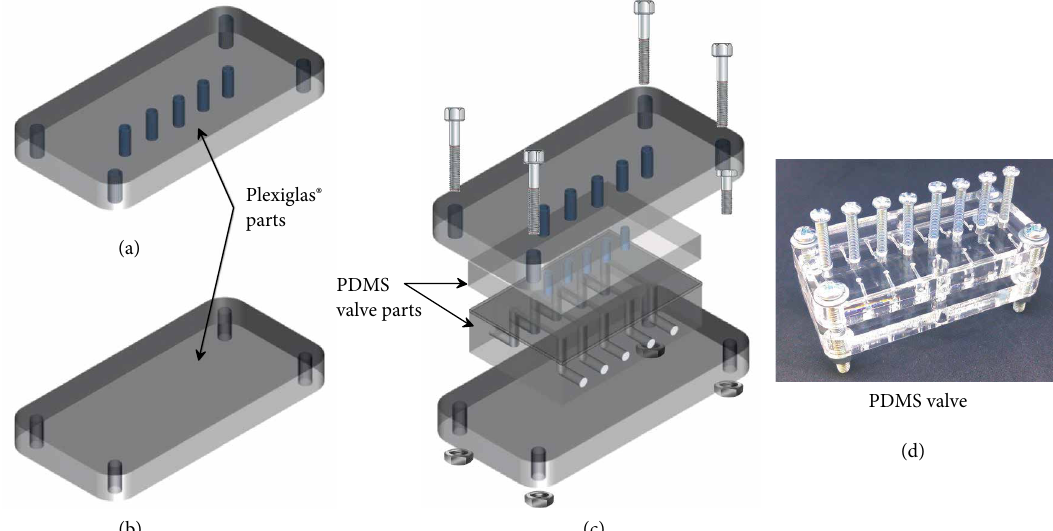
Figure 4: Description of the Plexiglas clamp design and the assemblage of the valve system. (a) and (b) Top and bottom support, respectively; (c) Assemblage of PDMS valve channels to Plexiglas clamps. (d) Final PDMS